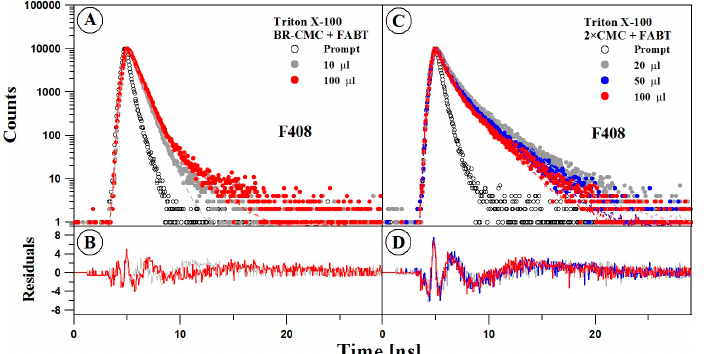
Figure 9. Effect of different FABT content in Triton X-100 (different concentrations) on the fluorescence decay of FABT (Panels ( A , C )). In Panels ( A , C ), the dotted curves show the decay of FABT fluorescence emission observed using the TCSPC technique in the micellar system, while continuous lines are double exponential fits (grey—10 µ L of FABT (BR-CMC), red—100 µ L of FABT (2 × CMC), blue—50 µ L (CMC) of FABT in all panels). Panels ( B , D ) show residual plots (determined for the data in Panels ( A , C )). The excitation pulse profile set up at 372 is indicated by the black dotted curve. The measurements were performed at the temperature of 22 °C.